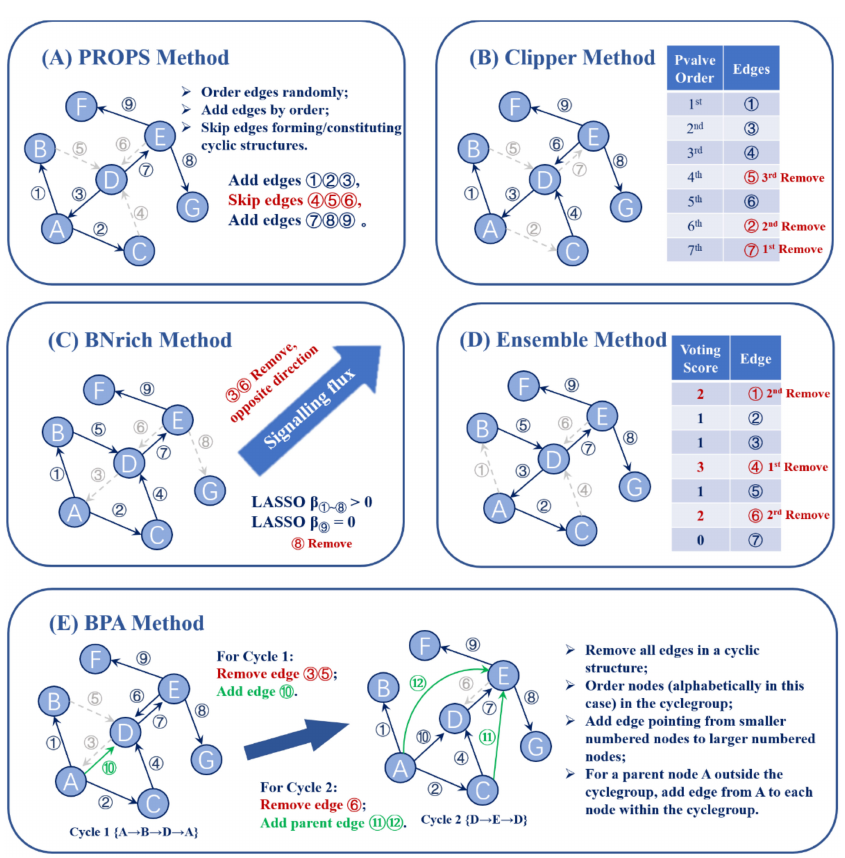
Figure 2. Schematic illustration of five BN reconstruction strategies. A hypothetical gene network, constituting 7 nodes (genes) and 9 edges is synthesized as an example to present the principle of each BN reconstruction method. Three cyclic structures {A -> B -> D ->A}, {A -> C -> D -> A}, and {D->E->D} are introduced in this network. ( A ) PROPS method orders each edge randomly and adds edges one by one. The edges that lead to cyclic structures are abandoned. Here, edge ④ , edge ⑤ , and edge ⑥ are removed. ( B ) Clipper method excludes cyclic edges with the most undesired p -value from the linear regression significance test. Edge ② , edge ⑤ , and edge ⑦ are the lowest-ranked in three cyclic structures thus removed. ( C ) BNrich method firstly removes cyclic structures according to intuitive biological rules, herein edge ③ and edge ⑥ due to them being opposite in the direction of signaling transmission. Additionally, BNrich employs LASSO to further simplify the network. The coefficient of edge ⑨ is shrunken to zeros during LASSO regression, thus removed. ( D ) Ensemble method breaks cycles and preserves its graph hierarchy as much as possible. Edges in a cyclic structure with the highest voting score are excluded, Herein edge ① , edge ④ , and edge ⑥ are removed to break corresponding cycles. ( E ) BPA method orders nodes arbitrarily (here in alphabetical order) and adds new edges from smaller numbered nodes to larger numbered nodes. Parent nodes of cyclic structure are also connected to each of the nodes in the cycle. Firstly edge ③ and edge ⑤ are removed and edge ⑩ is added in cycle 1. Then edge ⑥ is removed and node A and node C, two parent nodes of node D, are connected to node E constituting edge ⑪